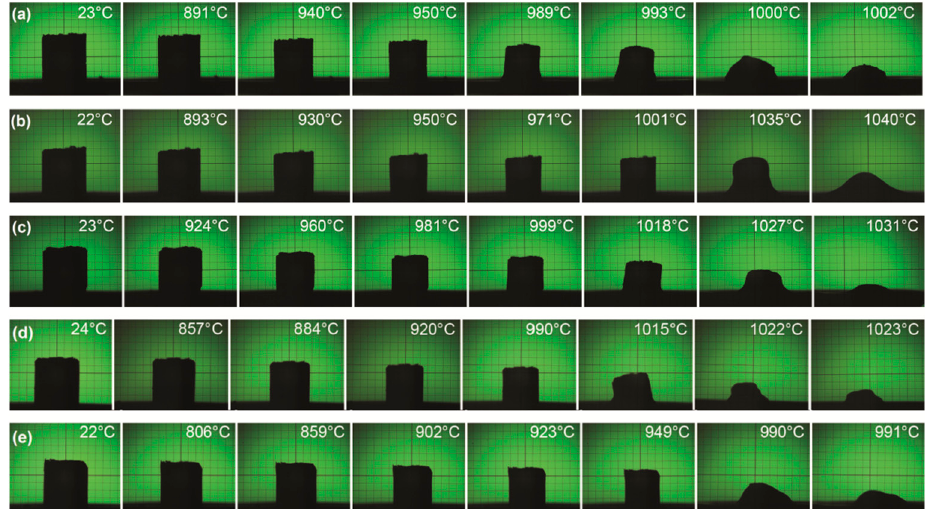
Figure 2. Selected images from a heating microscope for: ( a ) CuB 2 O 4 , ( b ) Cu 3 B 2 O 6 , ( c ) 65% CuB 2 O 4 – 35% Cu 3 B 2 O 6 , ( d ) 50% CuB 2 O 4 –50% Cu 3 B 2 O 6 doped with 5% CuBi 2 O 4 , ( e ) 30% CuB 2 O 4 –70% Cu 3 B 2 O 6 doped with 5% CuBi 2 O 4